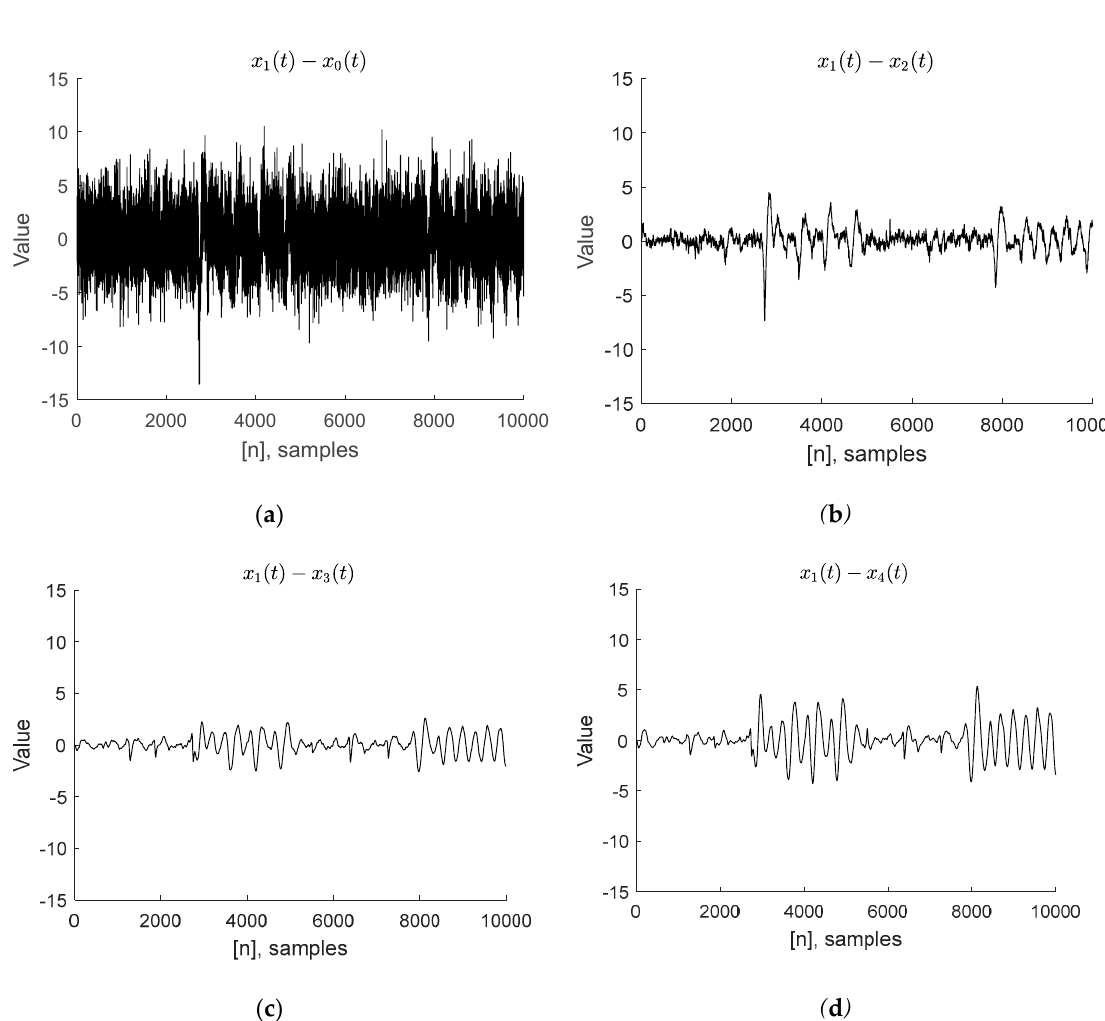
Figure 10. Restored message in noisy sequence 0101 (SNR = 0 dB) at the first stage ( a ), second stage ( b ), third stage ( c ) and forth stage ( d ).